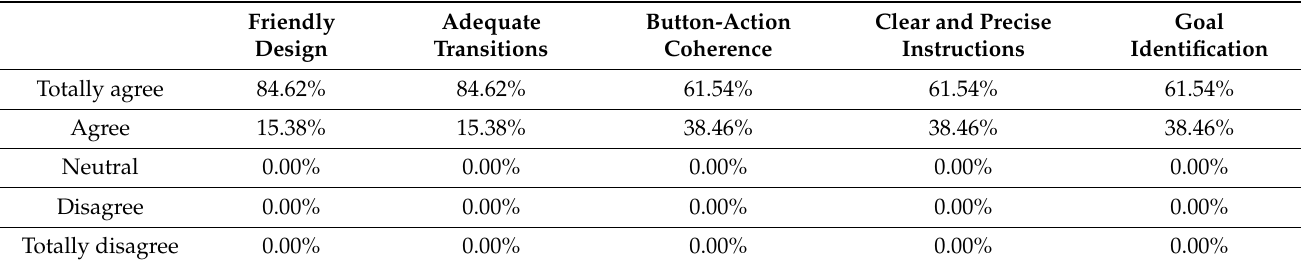
Table 1. Interaction and interface questionnaire: